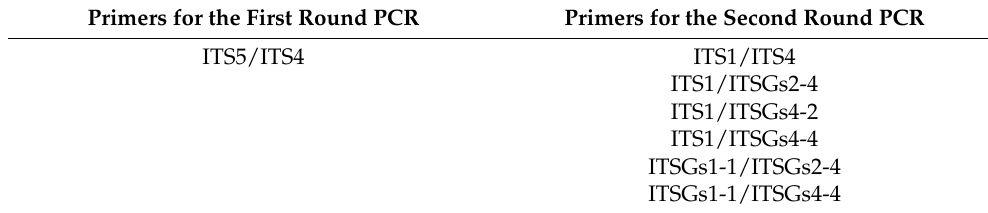
Table 2. Nested PCR primer combinations.